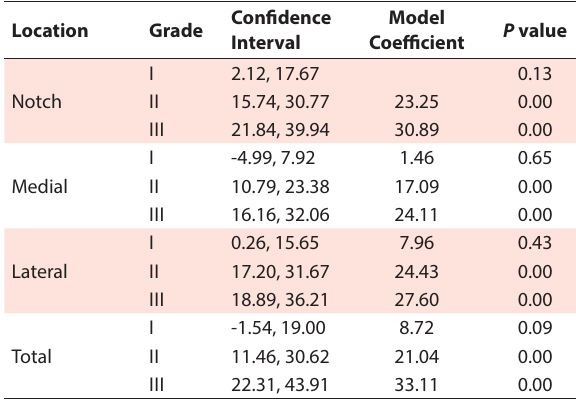
Table 3. Association between the trochlear cartilage grade and